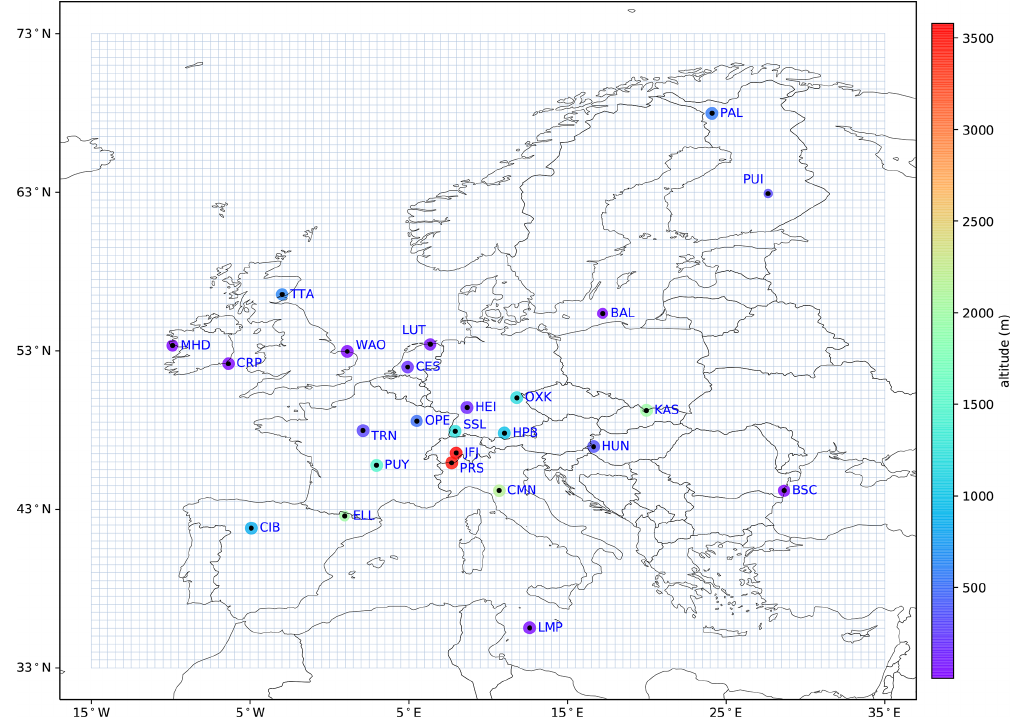
Figure 2. Regional inversion domain and location of the observation sites. The area of the dots is proportional to the number of observations available at each site (the actual number of observations is reduced by the filtering described in Sect. 3.4.4), and their color represents the altitude of the